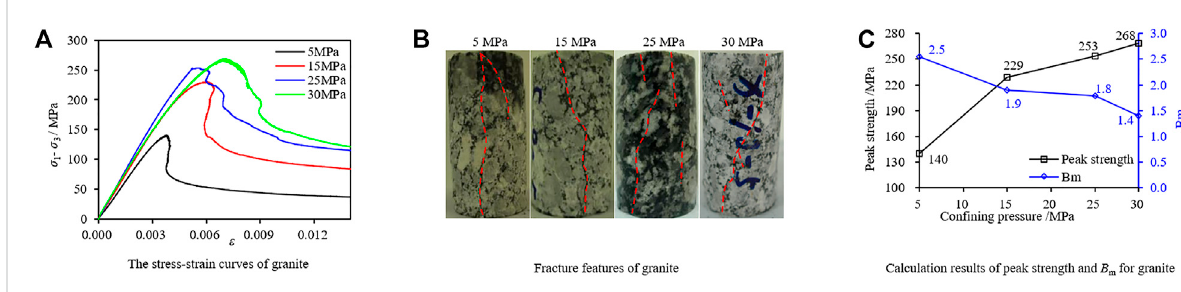
FIGURE 2 Test results and Bm values granite under different con fi ning pressures.